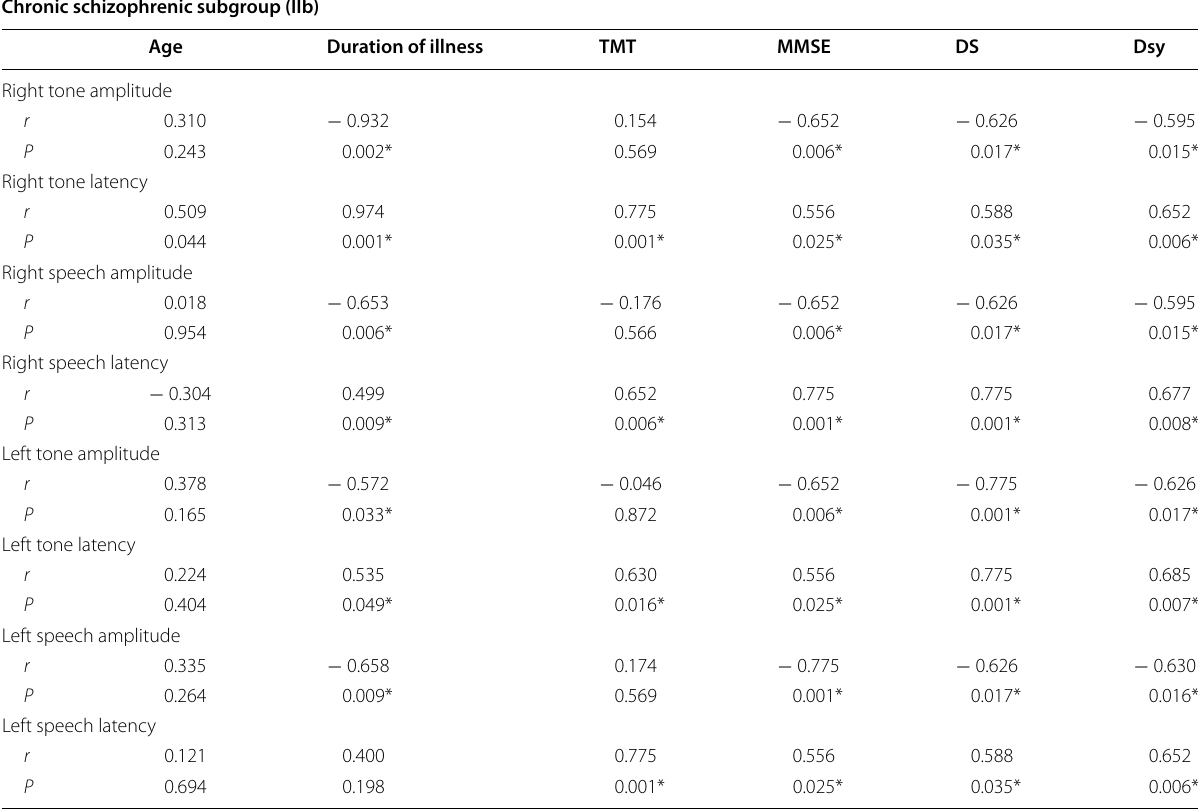
Table 4 Correlations between MMN parameters and each of the age, duration of illness and the studied psychometric scales in the right and left ears among chronic